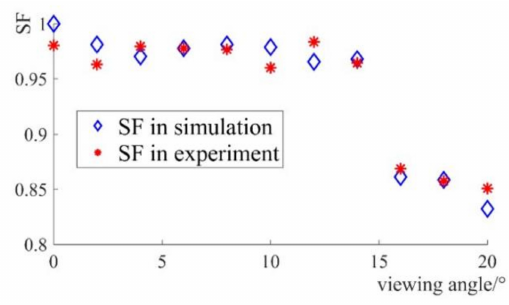
Figure 7. Comparison of similar factors by simulation and experiment.